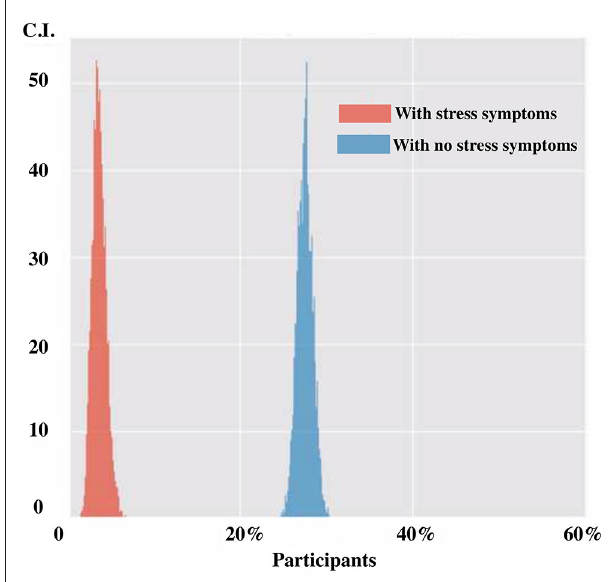
FIGURE 2 | Need for psychological support in participants with and without stress symptoms.